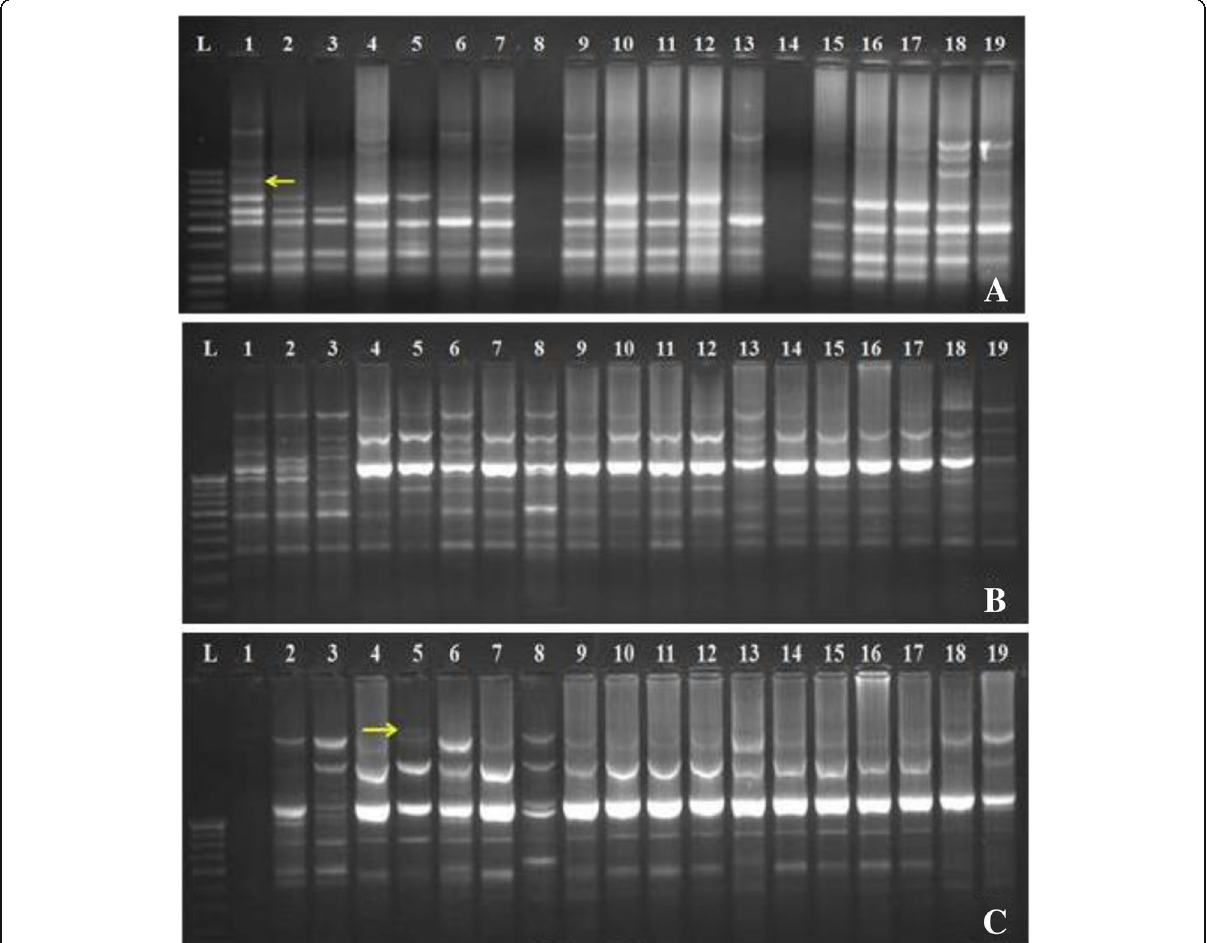
Fig. 1 Banding pattern of primers a ISSR 09, b ISSR 25, c ISSR 26 among grain amaranth genotypes (1: A. edulis ; 2: IC-381195; 3: IC-381135; 4: Deesa local; 5: EC-519549; 6: IC-1733; 7: Annapurna; 8: Durga; 9: BGA-2; 10: GA-1; 11: GA-2; 12: GA-3; 13: PRA-1; 14: PRA-2; 15: PRA-3; 16: PRA-4; 17: RMA-7; 18: Suvarna; 19: VL-44; L: 100 bp ladder; arrow indicates unique